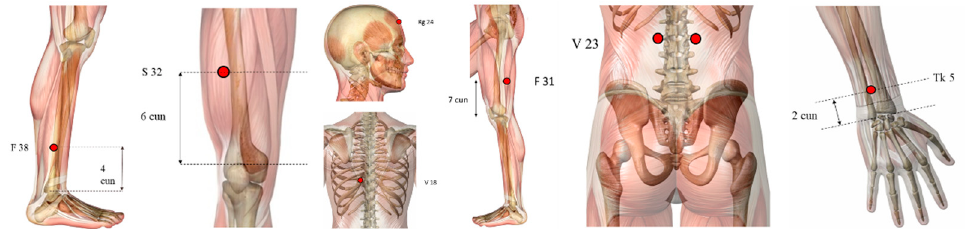
Figure 4. Illustration of the less frequent points used (highlighted in red dots):: TE5 ( Waiguan ), EX-HN-1 ( Sishencong ), BL23 ( Shenshu ), BL18 ( Ganshu ), ST32 ( Futu ), GB38 ( Yangfu ), GB31 ( Fengshi ) and GV24 ( Shenting ).